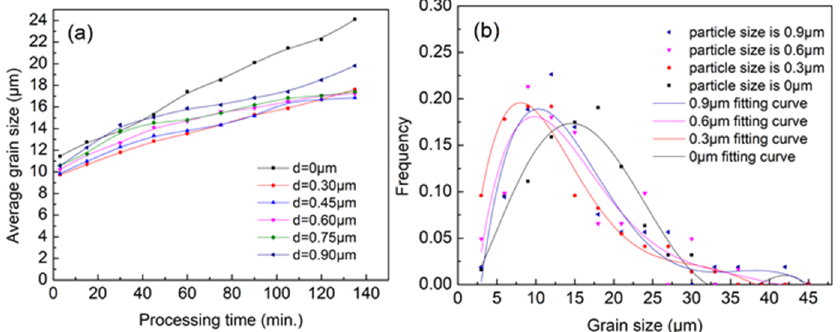
Figure 8. ( a ) The average grain size evolution at 573 K with second phase particles of different size under 135 MPa stress; and ( b ) the distribution of grain size with processing 60 min.